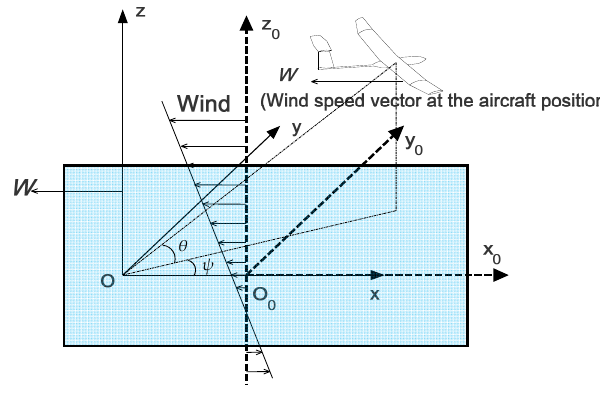
Figure 2. Coordinates and wind field.